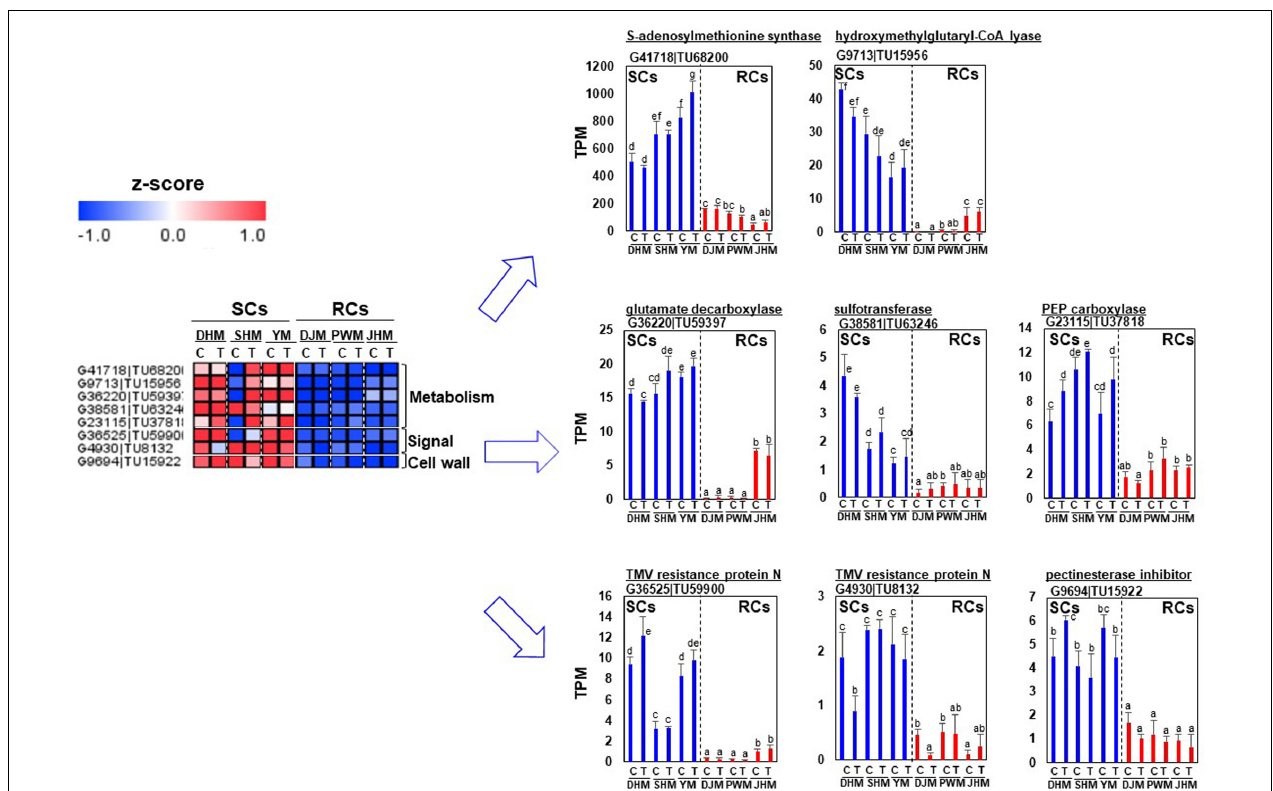
FIGURE 8 | Comparison of the expression levels of SC-specific candidate genes in six sweetpotato cultivars under control and RKN-infected conditions. DEGs related to metabolism, signals and cell wall were identified. The heatmap was constructed using Multi Experiment Viewer (MeV). DHM, Dahomi; DJM, Danjami; PWM, Pungwonmi; SHM, Shinhwangmi; JHM, Juhwangmi; YM, Yulmi; RCs, resistant cultivars; SCs, sensitive cultivars; C, control; T, treatment. Bars denoted with the same letter are not significantly different ( P = 0.05) according to Dunnett’s